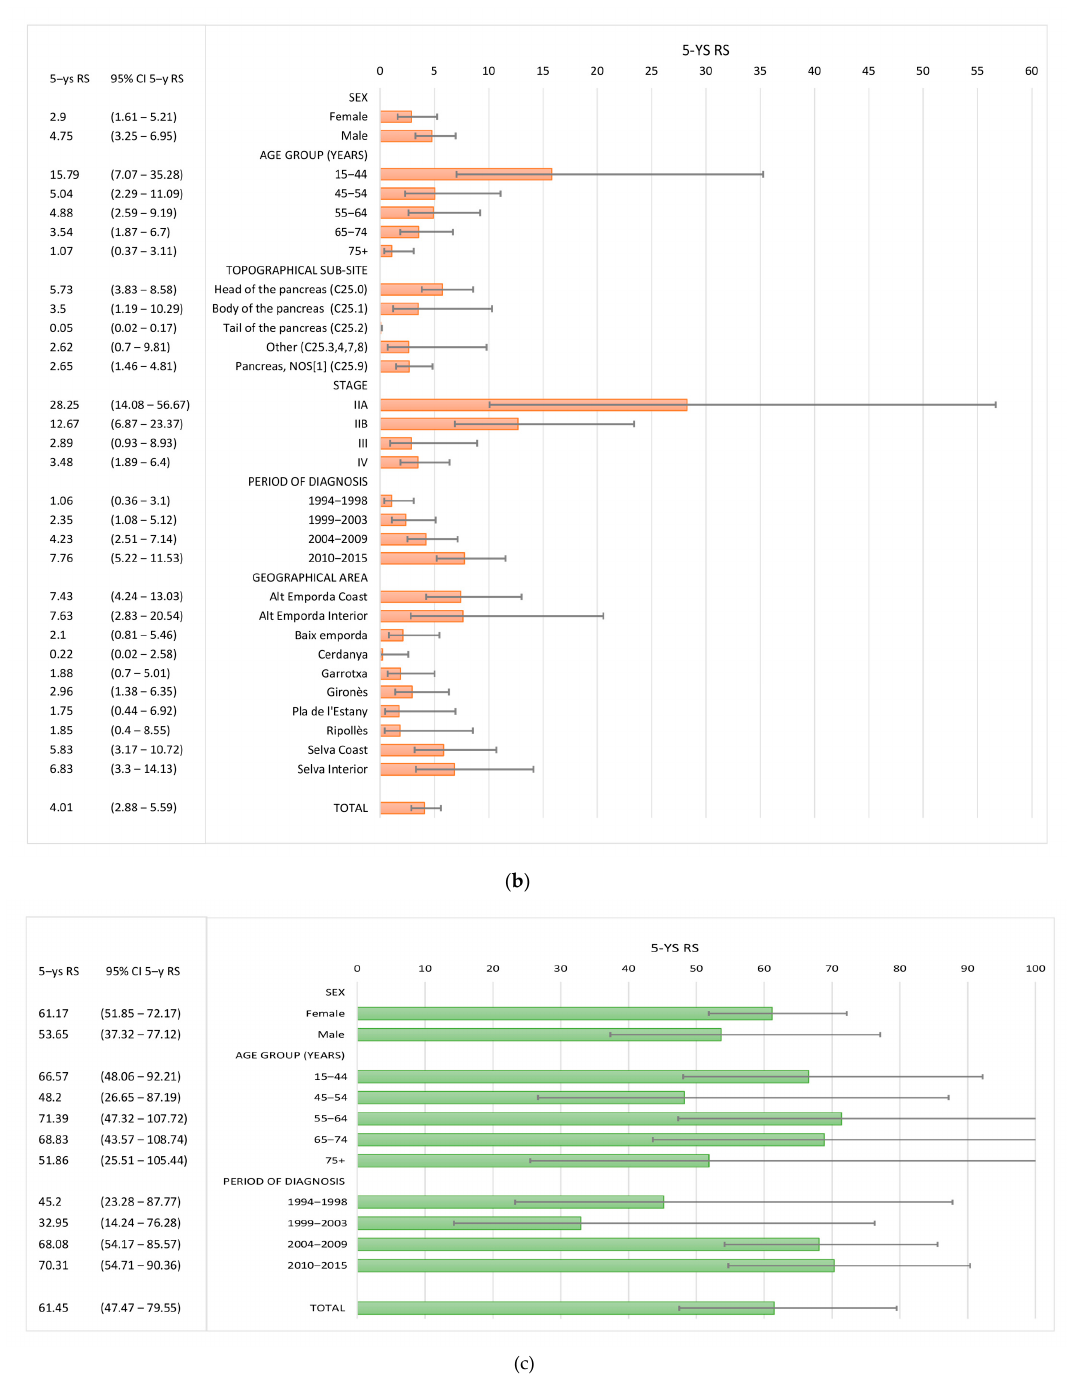
Figure 3. 5-year relative survival for all pancreatic cancers—PC ( a ), Pancreatic carcinomas non-neuroendocrine—Non PNETs ( b ) and Pancreatic neuroendocrine tumors—PNETs ( c ) by sex, stage, period of diagnosis, sub-site and county. Girona province, 1994–2015.